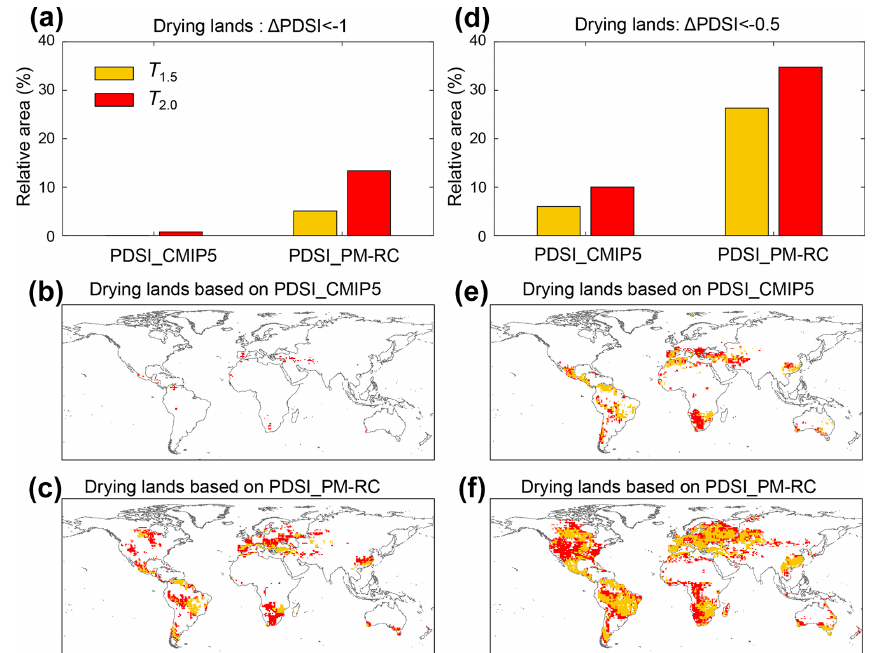
Figure 6. Areas with substantial drought increase under future warming. (a) Relative land area with substantial drought increase ( (cid:49) PDSI < − 1 . 0) under 1.5 and 2 ◦ C warming based on PDSI_CMIP5 and PDSI_PM-RC. (b, c) Spatial pattern of substantial drought increase ( (cid:49) PDSI < − 1 . 0) under 1.5 and 2 ◦ C warming based on (b) PDSI_CMIP5 and (c) PDSI_PM-RC. (d–f) Similar to panels (a) – (c)